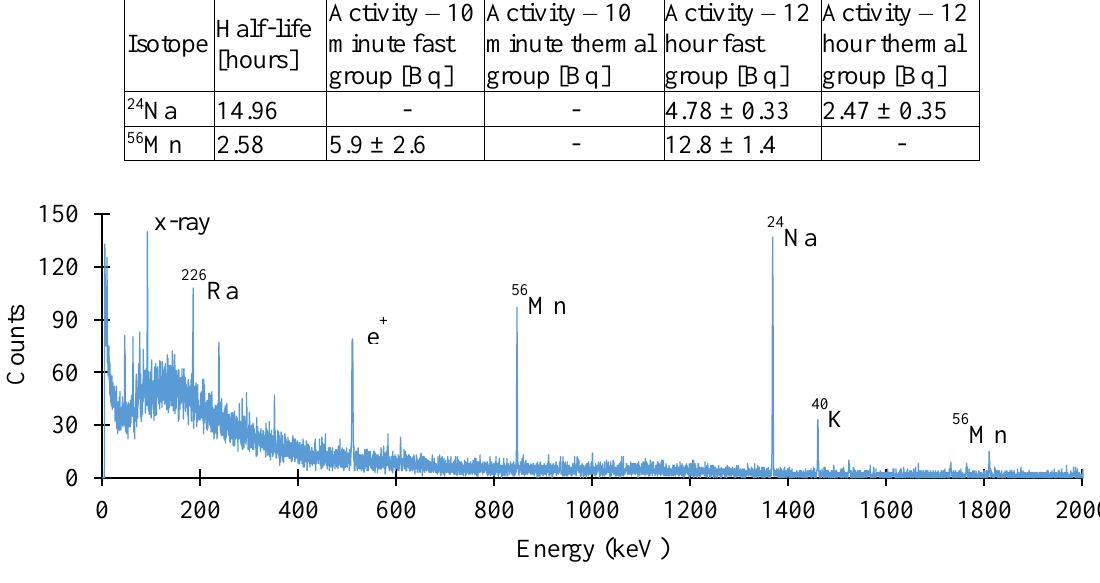
Figure 1: Example spectrum for the 12-hour duration fast group measurement showing the presence of 24 Na and 56 Mn along with background isotopes.